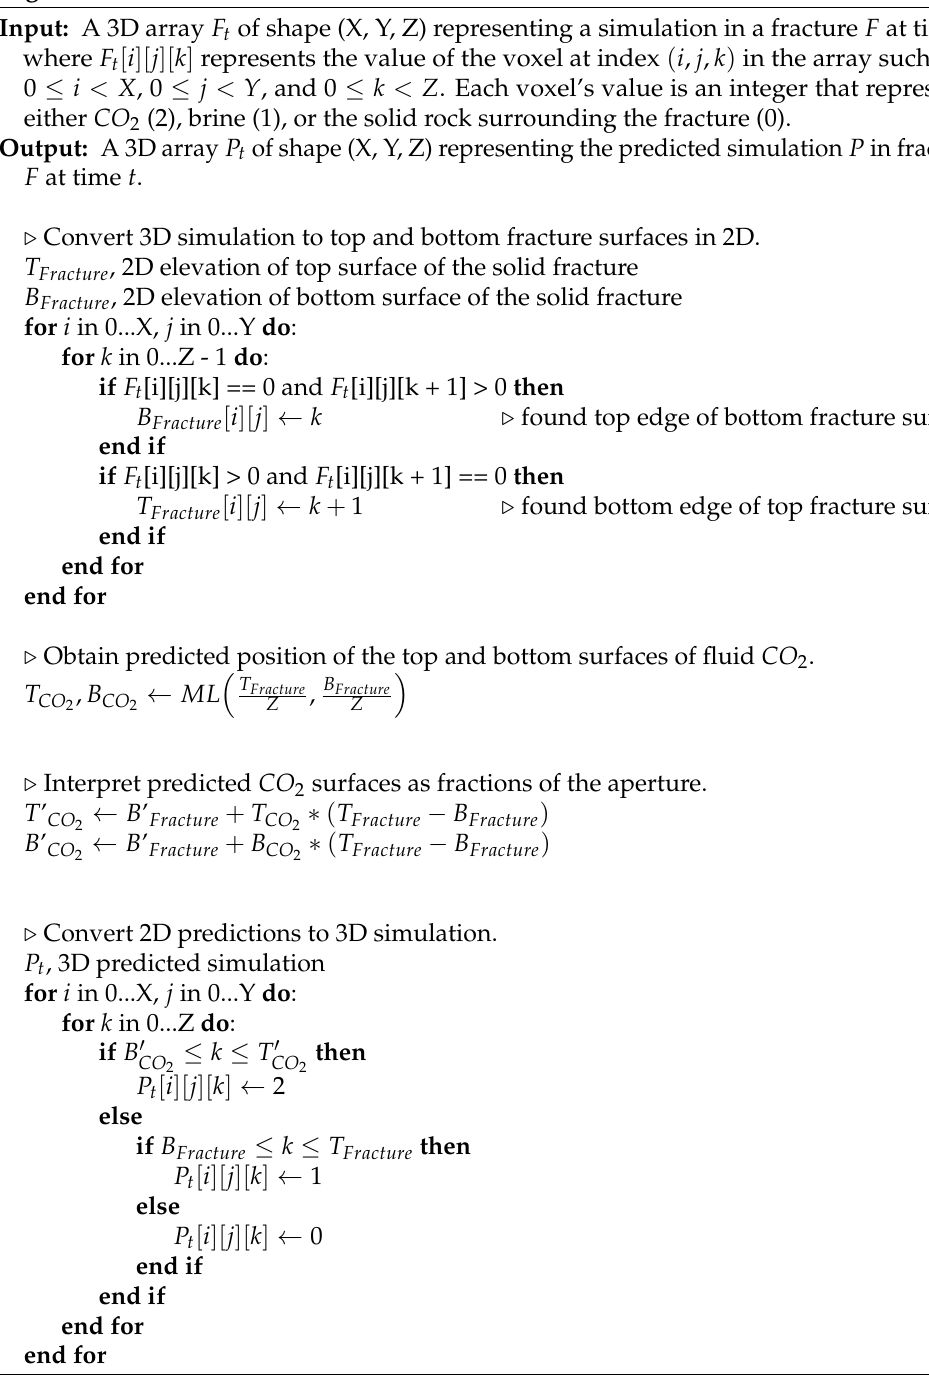
Algorithm 1 3D to 2D fracture